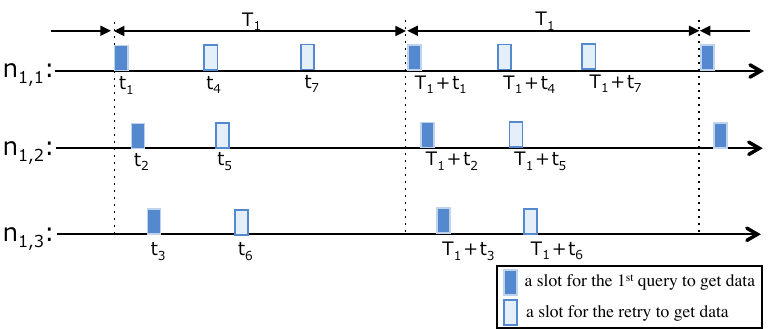
Figure 1. An example of polling schedule in a monocycle polling